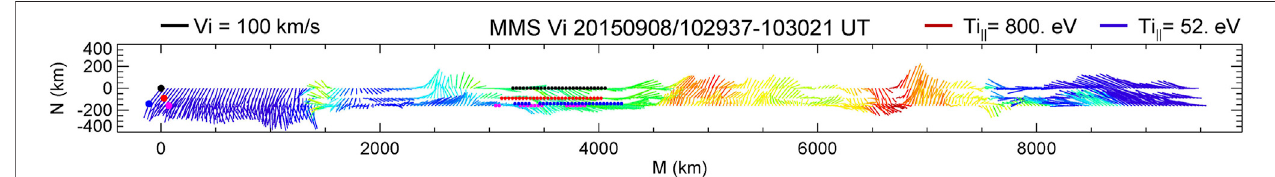
FIGURE6| XY GSM -planeionvelocityvectors(150 ms cadence) aredisplayed alongthefour MMS satellite propagation directions M GSM (cid:1) [0.717852, − 0.696196, 0.0]with N GSM (cid:1) [0.696196,0.717852,0.0]asadirectionorthogonaltotheMMStetrahedrontrajectory.Time(t)isconvertedintodistanceM (cid:1) | V KH | · tforthetimeperiod 1029:37 – 1030:21UTand V KH (cid:1) − 216.4 · M GSM km/s.Thevectorsarecolor-codedusingalinearcolorscalethatcorrespondstothemeasuredparalleliontemperatureat each satellite with Ti || ∼ 800 eV (red) and Ti || ∼ 52 eV (blue). The M-component of the ion GSM velocity is shown in a tailward KH-vortex moving system with Δ V M (cid:1) V M − ( − 216.4)km/s.The[0,0]coordinatede fi nesthet (cid:1) 0startpositionoftheMMS-1satellite(blackdot)inthisMN-planeat1029:37UTwiththestartpositionsofMMS-2 (red), MMS-3 (pink) and MMS-4 (blue) shown with their tetrahedron positions relativeMMS-1 ( see text for detailed positions).The colored, smaller dots near 3000 < M < 4250 km mark the spatial coordinates where the four MMS satellites recorded two counter-streaming ion beams ( see text for detailed